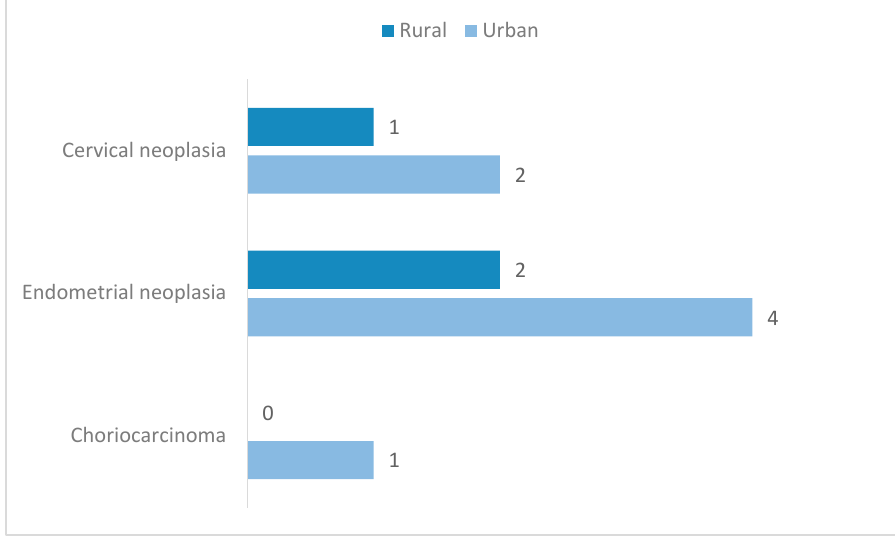
Figure 4. Neoplasia histopathological diagnoses distribution on patient background. Data are presented as N .